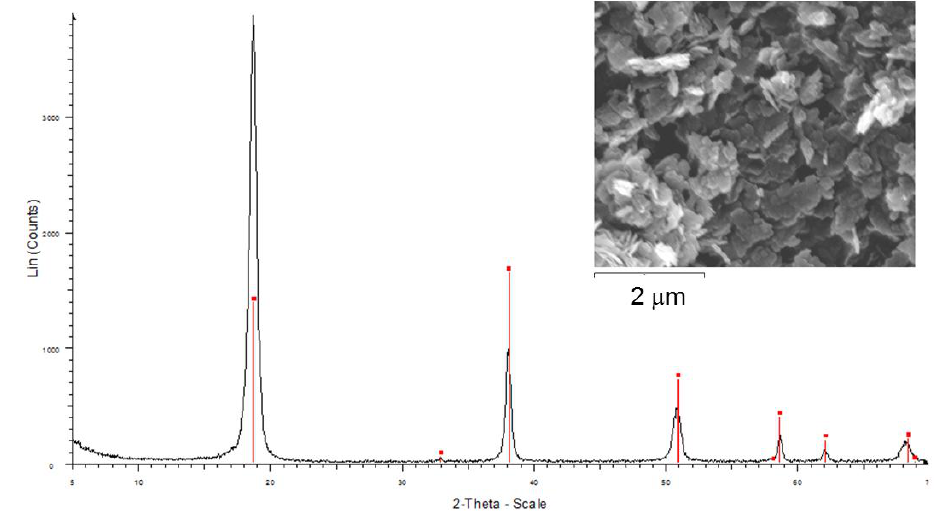
Figure 3. XRD pattern and SEM of the brucite sample (B).